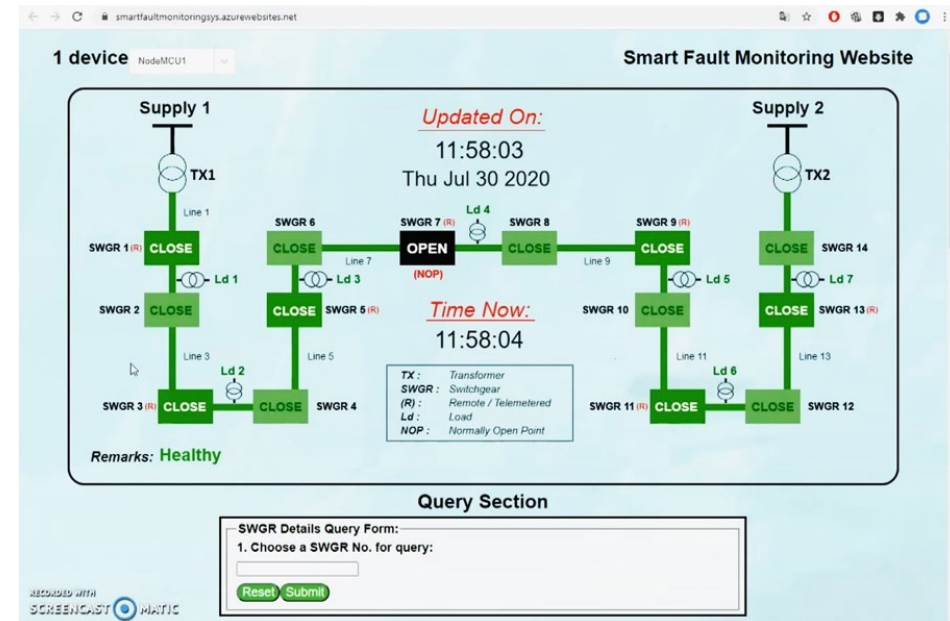
Figure 11. Smart fault monitoring website.